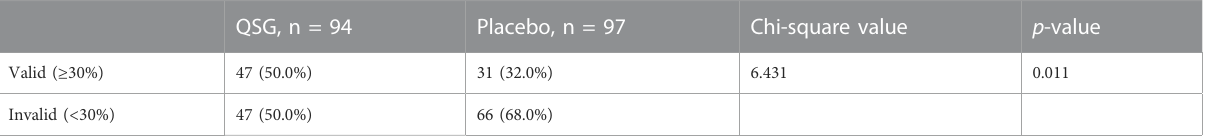
TABLE 2 Treatment ef fi ciency in NT-proBNP.